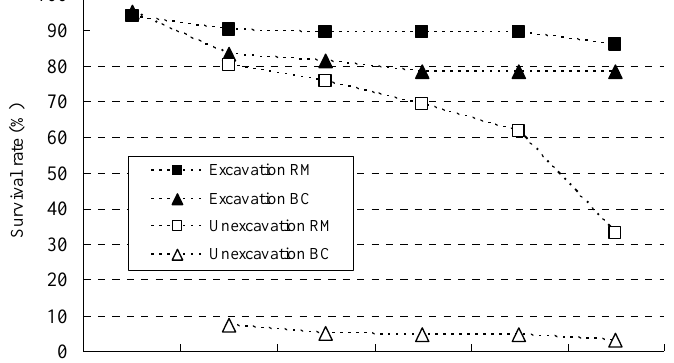
Figure 6. The survival rate of Rhizophora mucronata (RM) and Bruguiera cylindrica (BC) from 5 months to 10 years after planting